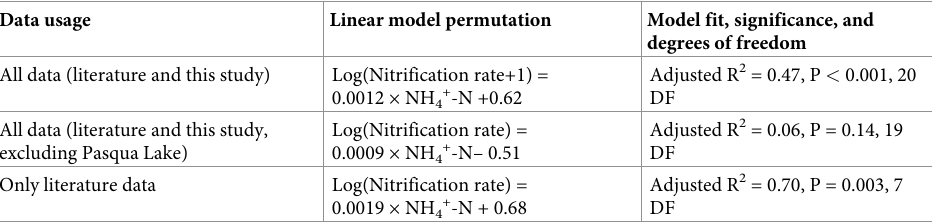
Table 3. Linear model relationships between nitrification rates ( μ g N L -1 d -1 ) and NH 4+ concentrations ( μ g N L -1 ), using the linear permutations modeling approach. Literature data sources are noted in the caption of Fig